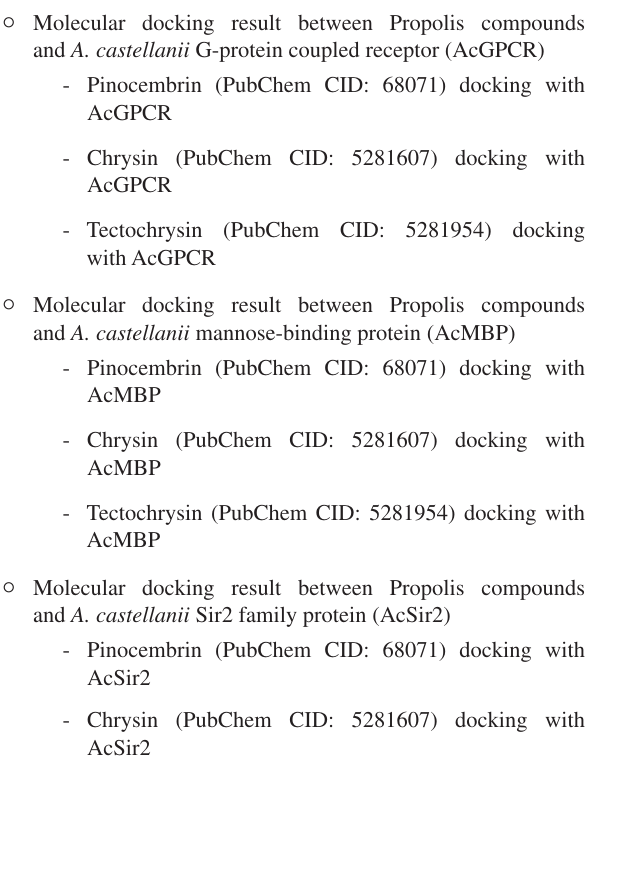
Figshare: Raw data for Molecular docking. https://doi.org/10.6084/ m9.figshare.21214079 41 .